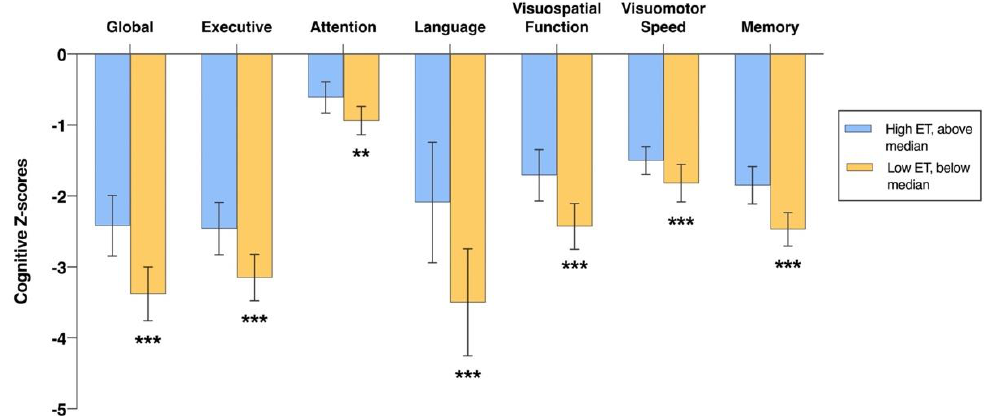
Figure 1. Baseline measures of global and domain-specific cognitive z-scores for high and low ET subjects. Bar graphs represent the estimated marginal means from the linear regression models, with error bars representing 95% confidence intervals. Group median ET was used as a cut-off point for High ET vs. Low ET designations. Analyses are shown with adjustments for age, gender, education, APOE ε4 status, hypertension, diabetes, and cardiovascular disease. ** and *** indicate significant associations based on multiple linear regression at p < 0.01 and p < 0.001, respectively. Abbreviations: ET = ergothioneine. Table 2. Baseline associations between plasma ET and cognitive performance. Mean Difference in Baseline Cognitive Z-Scores per Unit